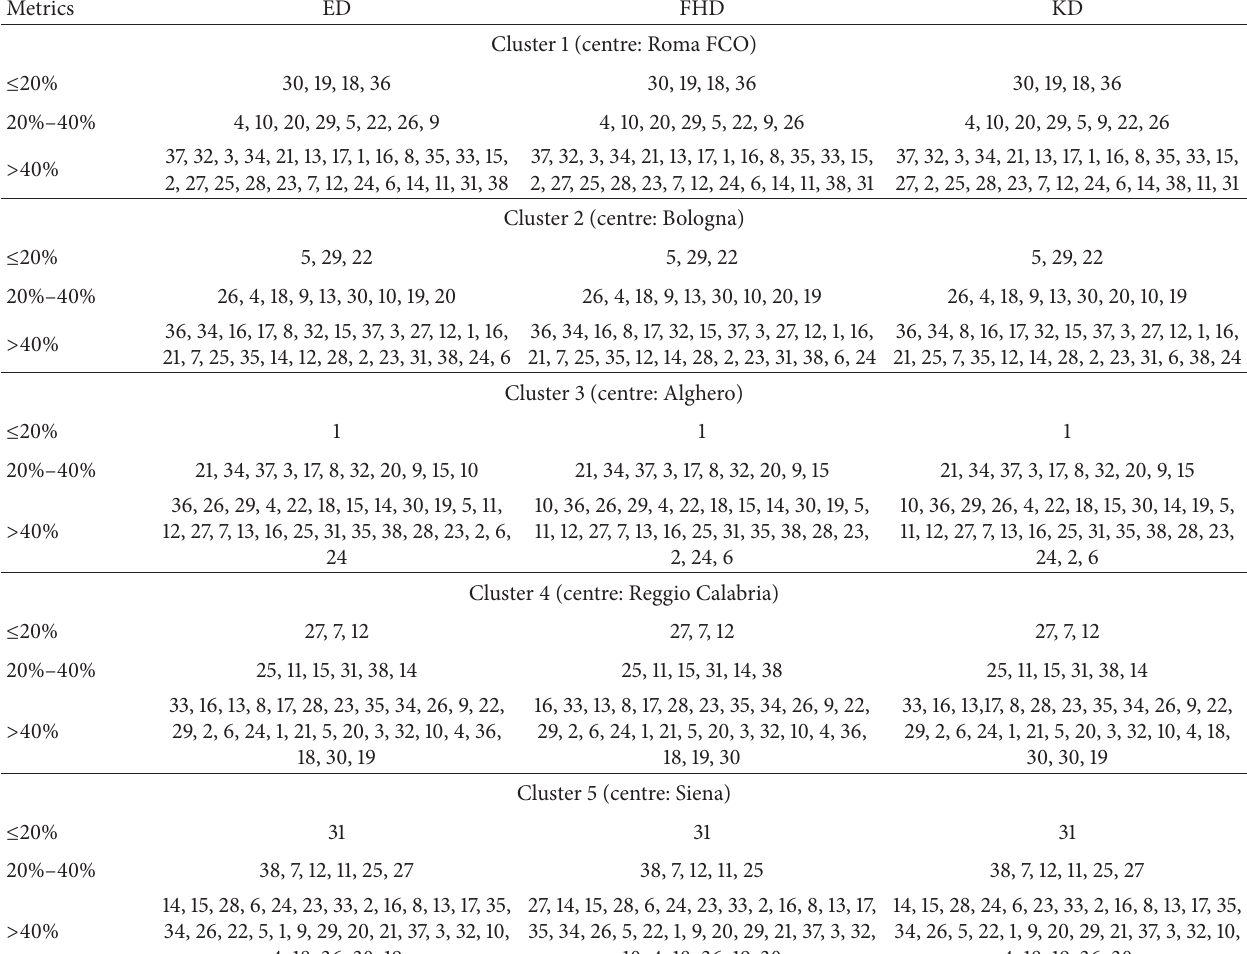
Table 4: Clustering results without prefixing the number of clusters. Criterion: yearly